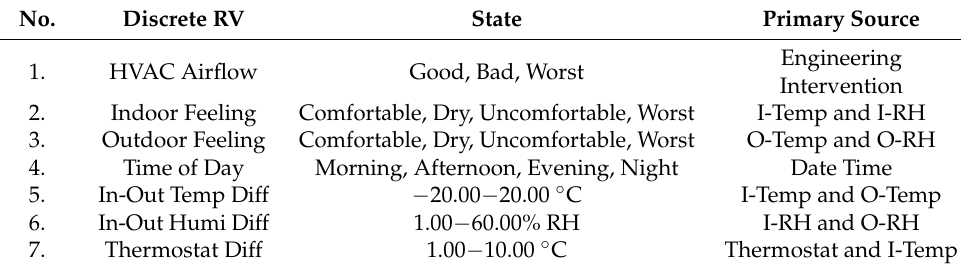
Table 2. The high-level information based on RVs for thermal comfort